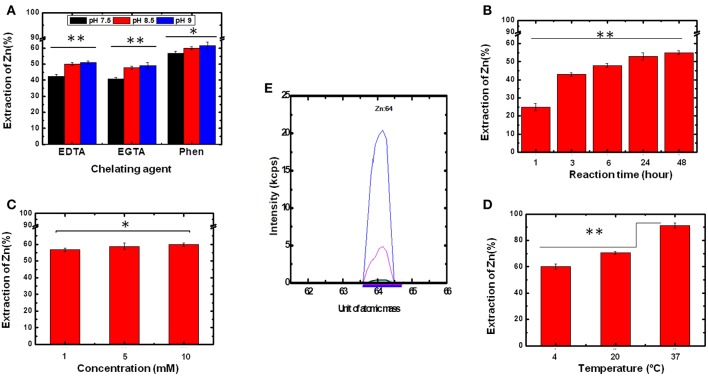
Determination of the optimum conditions for Zn removal. To determine the best experimental parameters for the removal of bound Zn, several conditions were tested. Statistical analyses were performed using ANOVA and considered significant for *p > 0.05 and **p < 0.05. (A) Chelating agent and pH. (B) Reaction time. (C) Chelating agent concentration. (D) Temperature. (E) ICP-MS spectra of purified Ydj1 before (blue) and after (red) the use of the best conditions for Zn removal (see text for details). Blank control (black).